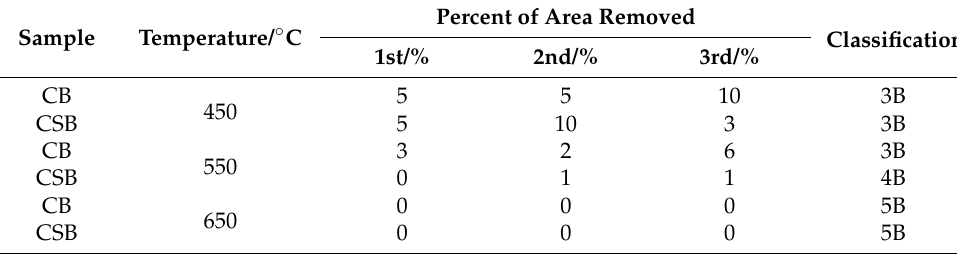
Table 1. The tape test results of functionalized ceramic tiles were sintered at different temperatures.